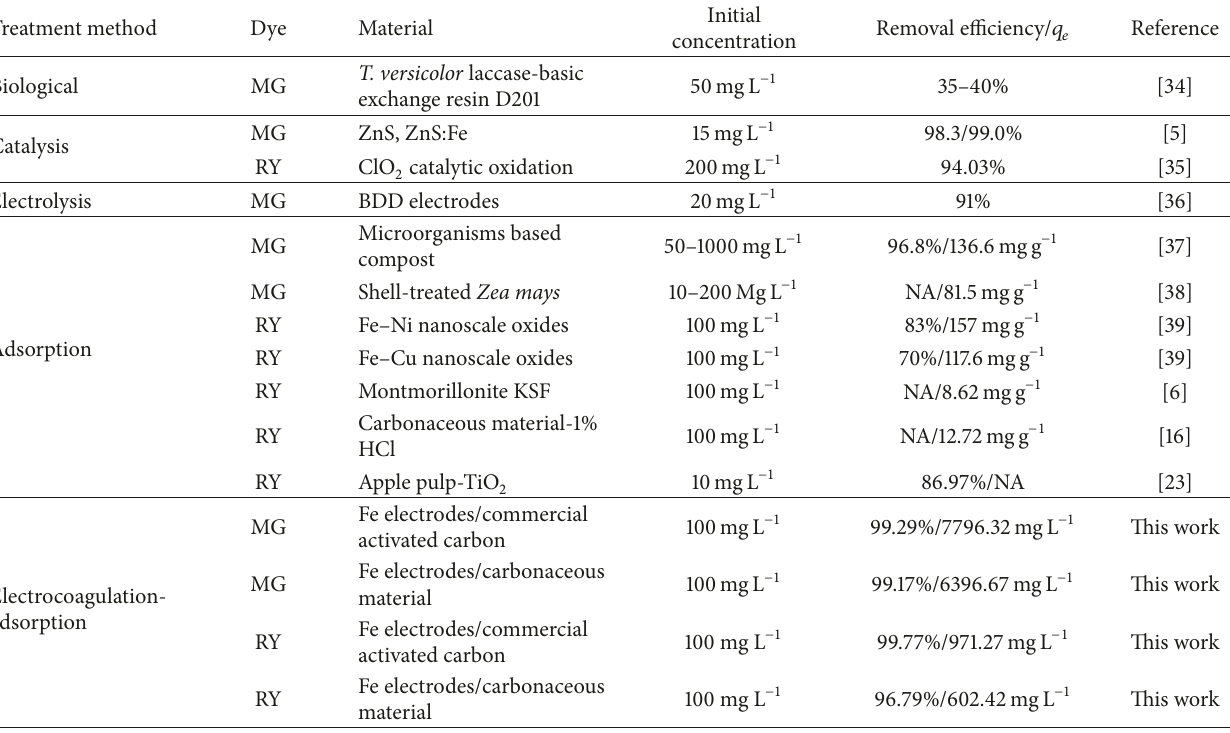
Table 4: Comparison of dye removal performances of various treatment technologies.